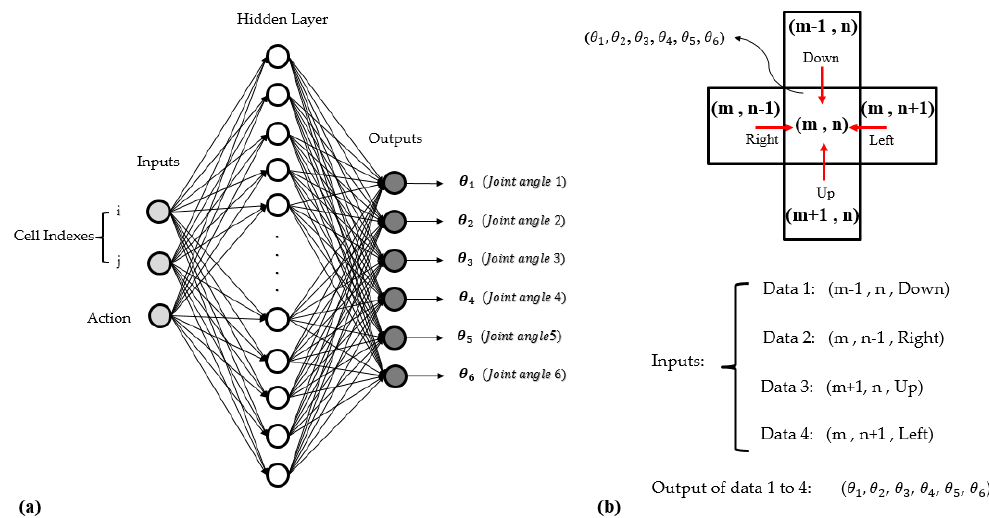
Figure 2. ( a ) Structure of the neural network. ( b ) Data acquisition sample through the vicinity cells.